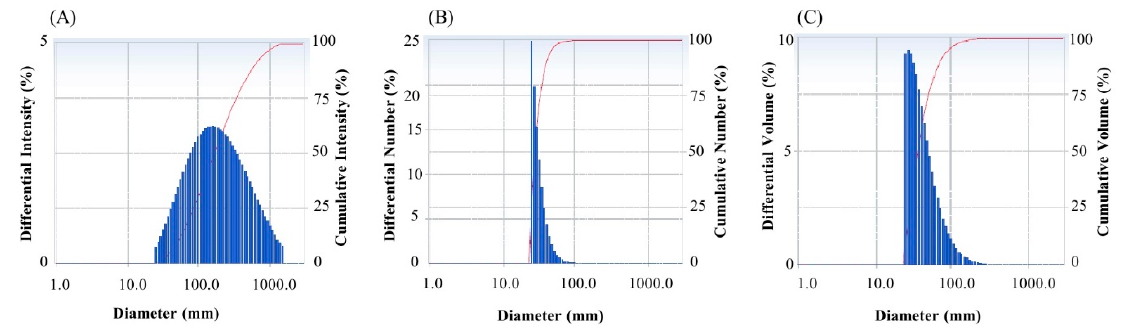
Figure 6. Particle size distribution of synthesized AgNPs according to intensity ( A ), number ( B ) and volume ( C ).